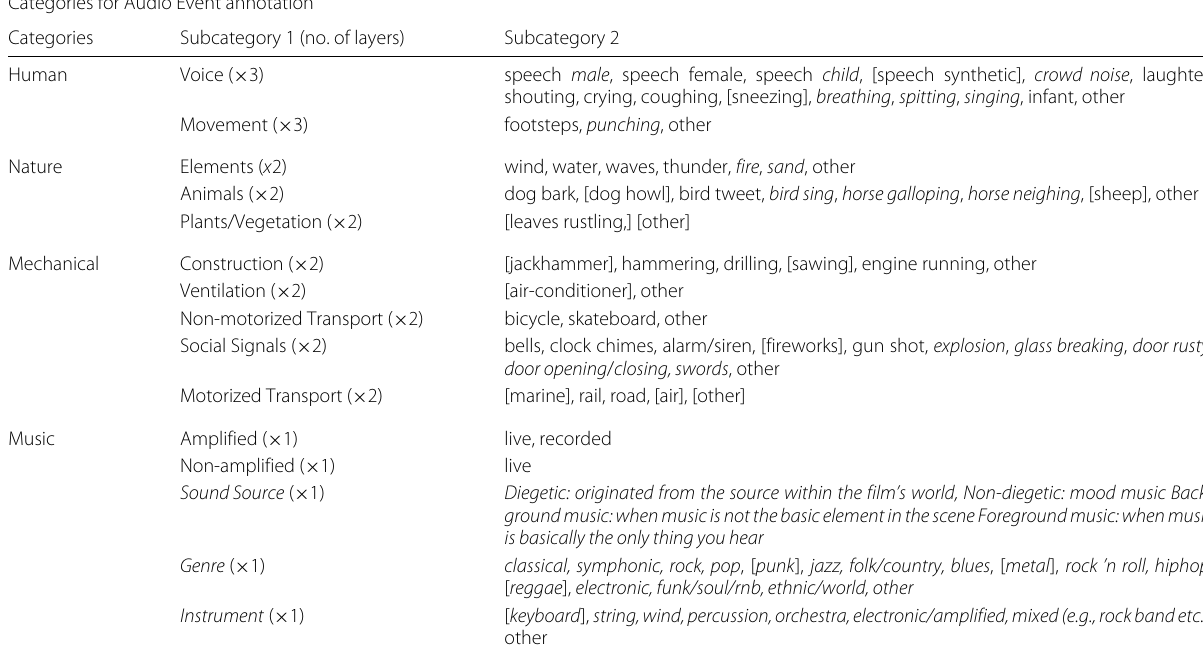
Table 4 Categories for audio event annotation Categories for Audio Event